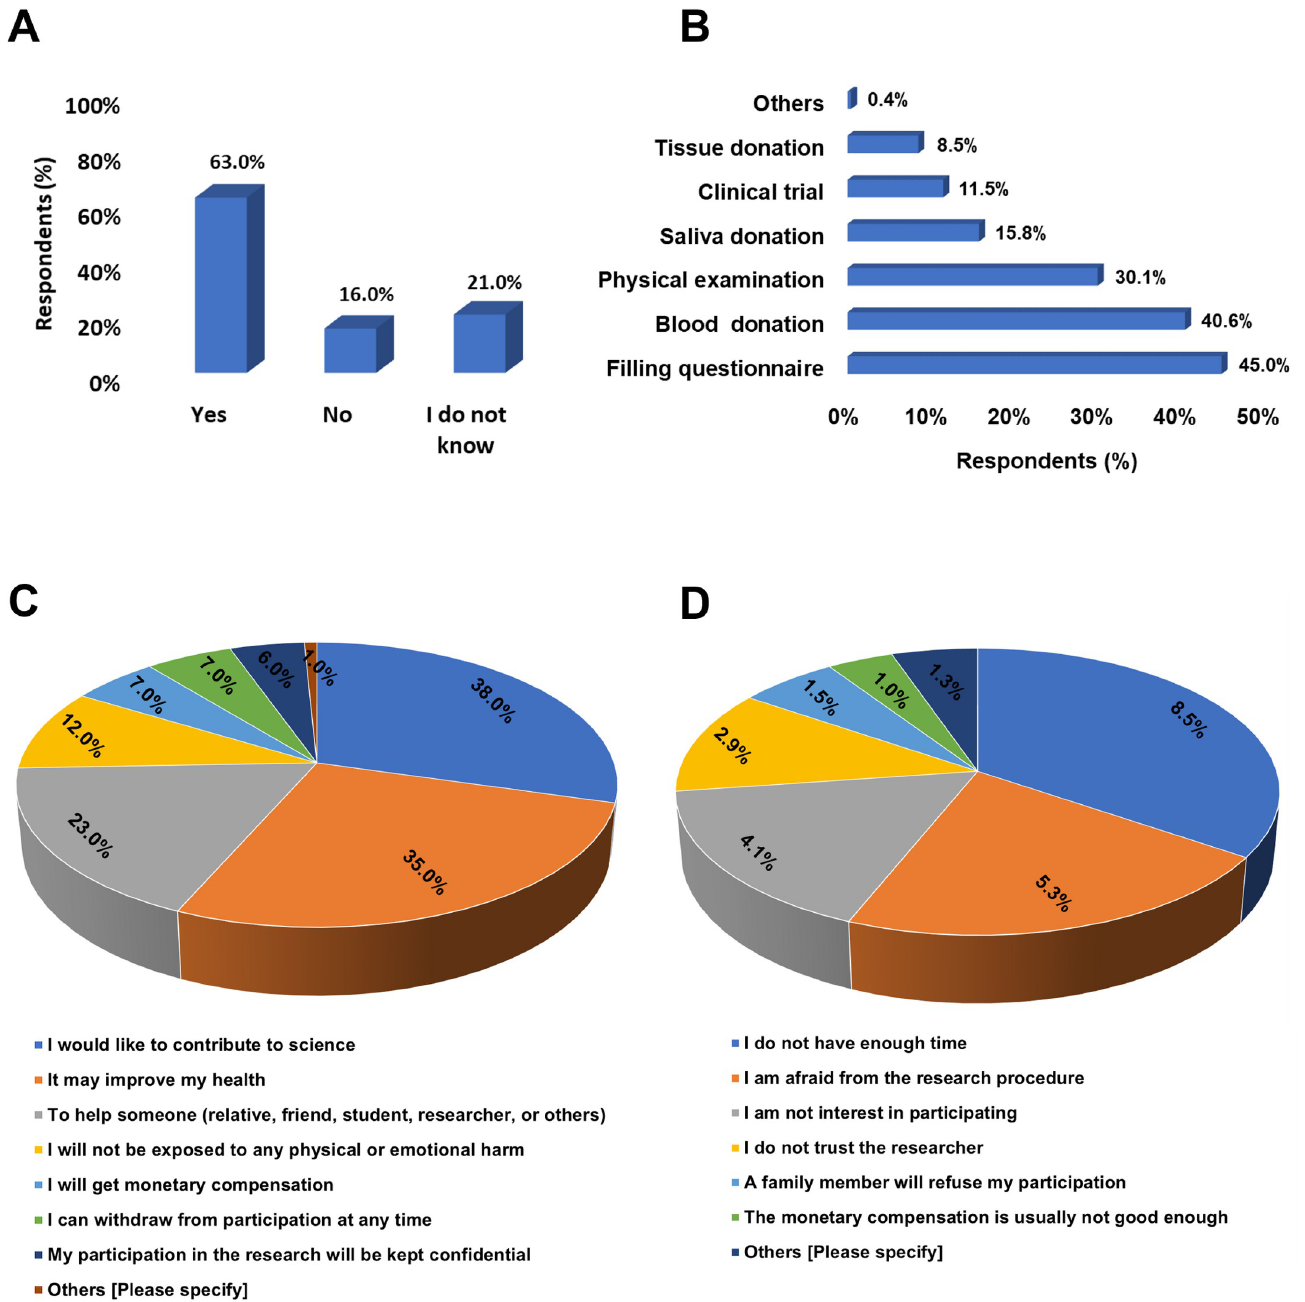
Fig 3. Assessing motivators and barriers towards future participation in clinical research. (A) Bar graph showing percentage of participants who are willing, not willing, or not sure to participate in future clinical research. (B) Bar graphic showing clinical research contributions that participants are willing to offer. (B) Pie graph showing perceived participation motivating factors for those who are willing to participate. (C) Pie graph showing perceived participation barriers for those who are not willing to participate. All responses are reported as percentages out of the total (N =